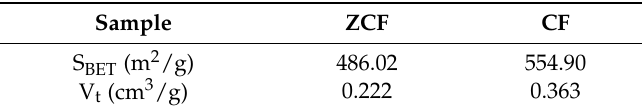
Table 1. Textural characteristic of ZCF and CF.